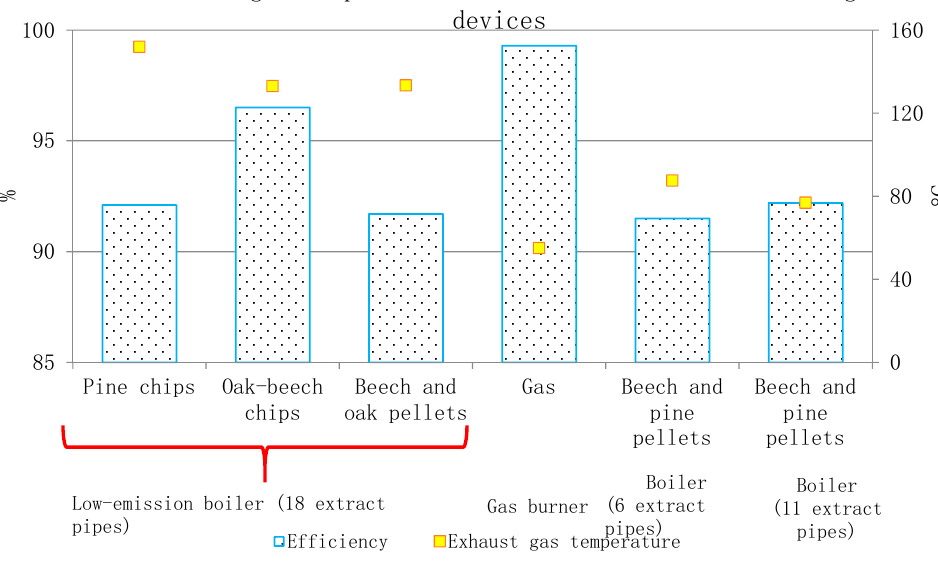
Figure 6. Comparison of exhaust gas emissions and efficiencies for the analysed heating devices powered by different fuels.